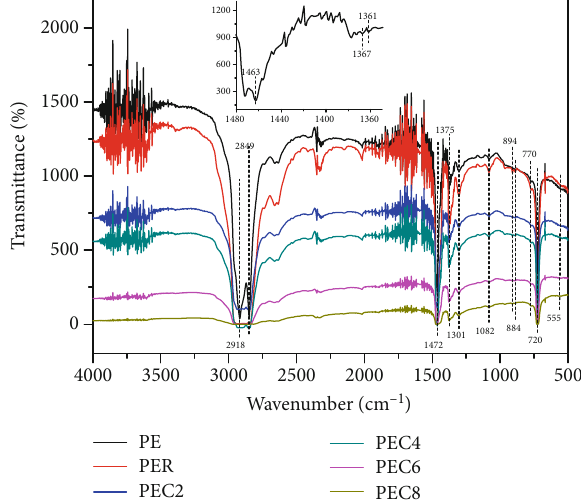
Figure 2: FTIR spectra of PE and its recycled